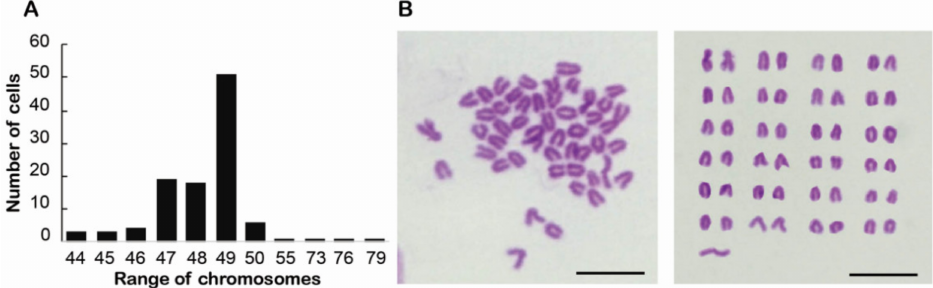
Figure 3. Chromosomes of CnGSC cells at passage 30, 50, and 70. ( A ). Analysis of chromosome distribution in cells. The main chromosome number was 49. ( B ) Metaphase chromosomes were mi- crographed after Giemsa staining. An example of a metaphase plate of CnGSC cells with hyperploid (49) chromosomes. (Bars = 10 µ m in ( B